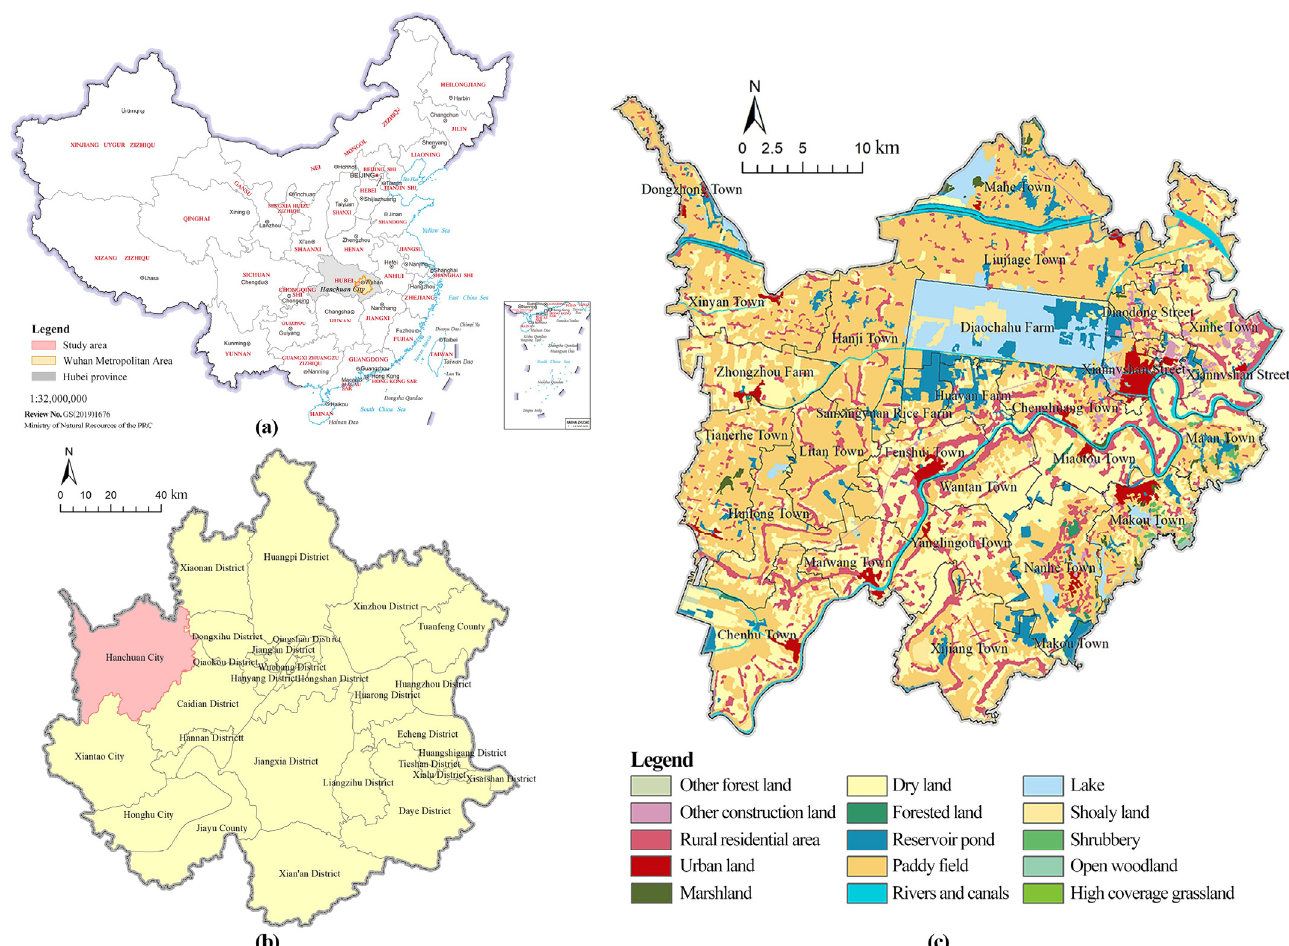
Figure 1. Study area. ( a ) Locations of the study area in China. ( b ) Locations of the study area in the Wuhan metropolitan area. ( c ) Land use of the study area. Wuhan metropolitan area. ( c ) Land use of the study